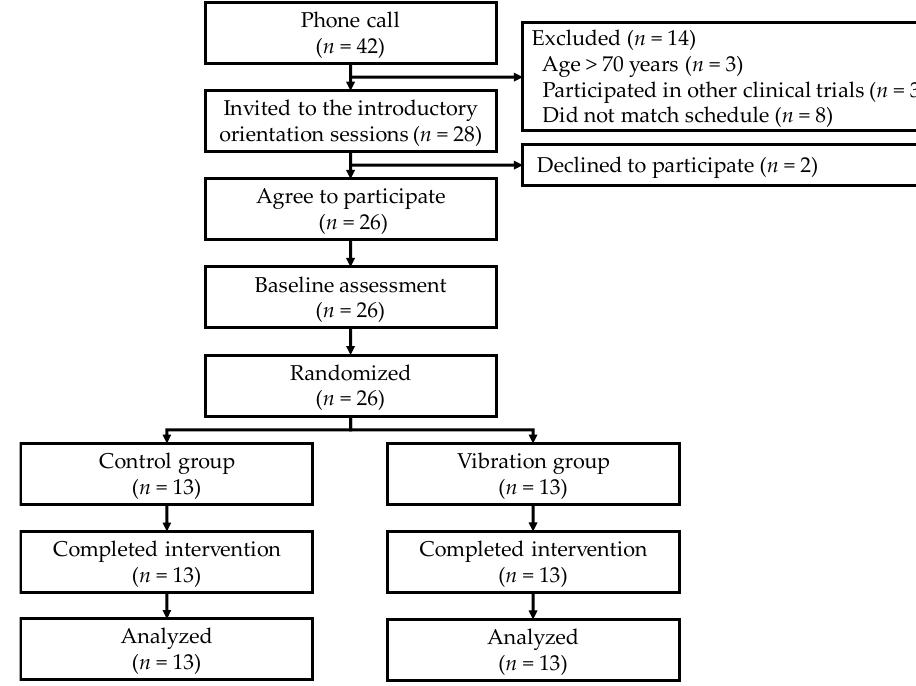
Figure 2. Participant flow from recruitment to end of trial.